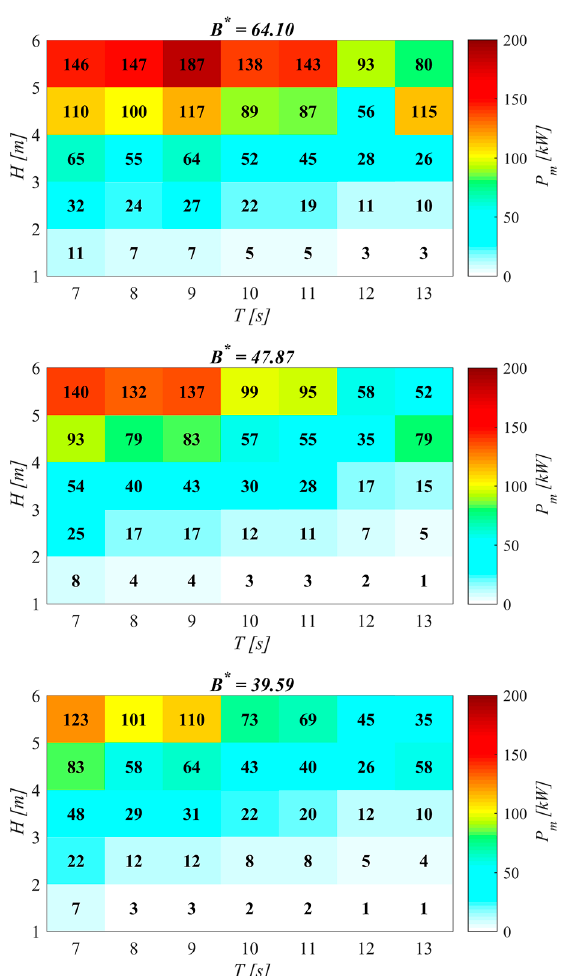
Figure 11. Power matrix showing the variation of the mean pneumatic power ( P m ) with the wave height ( H ) and period ( T ) for regular waves (Series A) and for different values of the damping coefficient ( B * ) (prototype data).